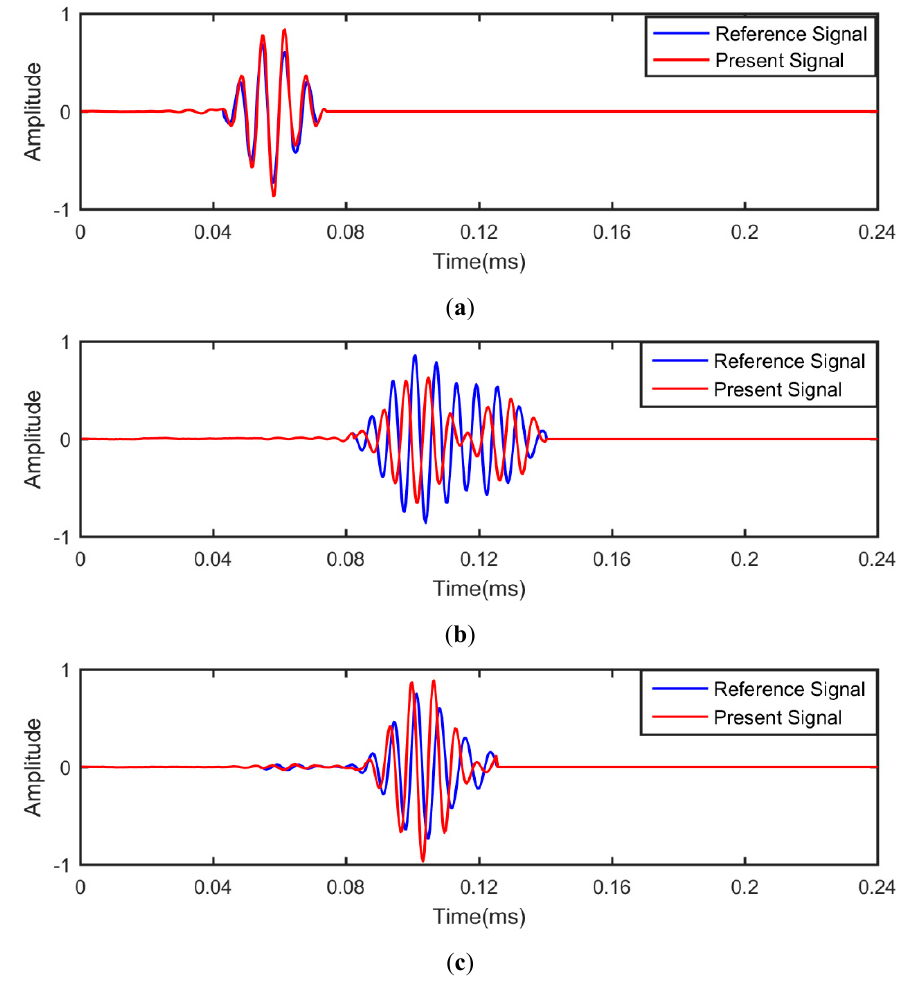
Figure 18. Lamb wave signals under different paths: ( a ) S1-transmitter, S2-receiver; ( b ) S1-transmitter, S5-receiver; ( c ) S2-transmitter, S6-receiver.